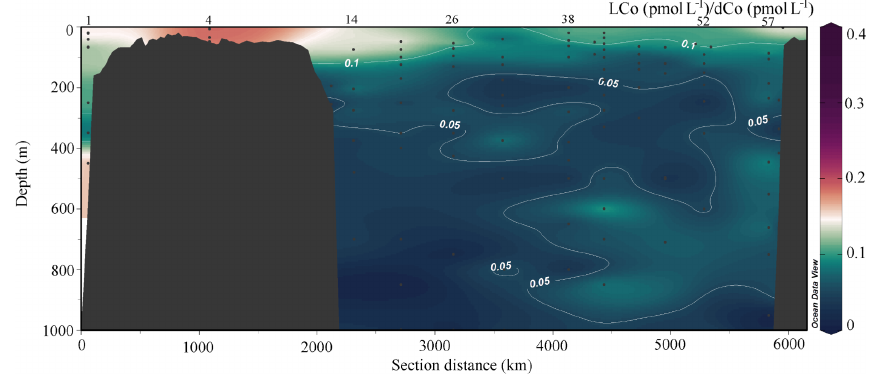
Figure 6. The ratio of LCo (pmolL − 1 ) to total dCo (pmolL − 1 ) along the transect from south to north in the upper 1000m.